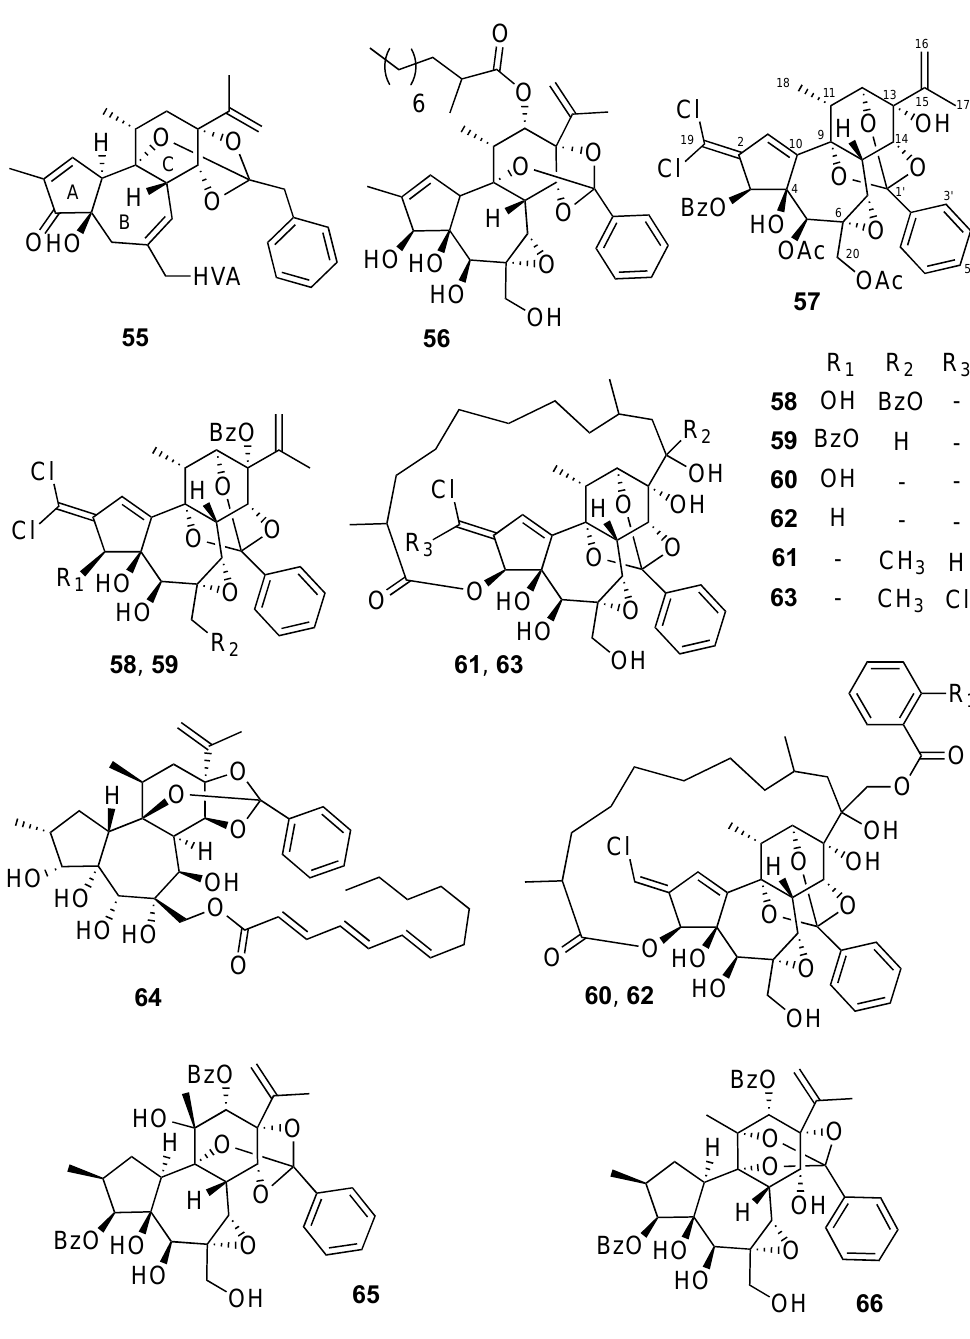
Figure 3. Structures of daphanes 55 – 66 .